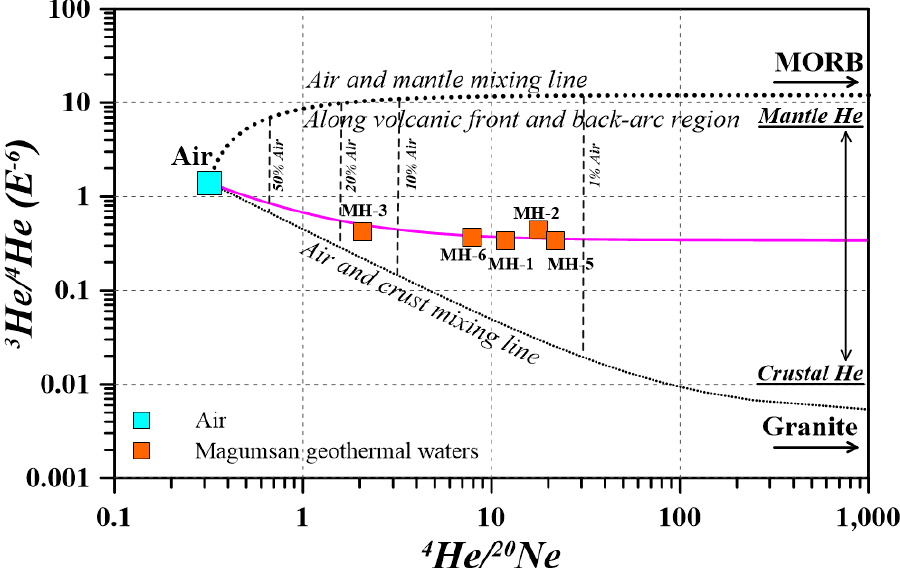
Figure 10. Three-end-member mixing diagram for He isotopic ratios in Magumsan thermal waters. (MH-3: 15.3% air contaminated sample; other samples: 1.5%–4.0% air contaminated samples).